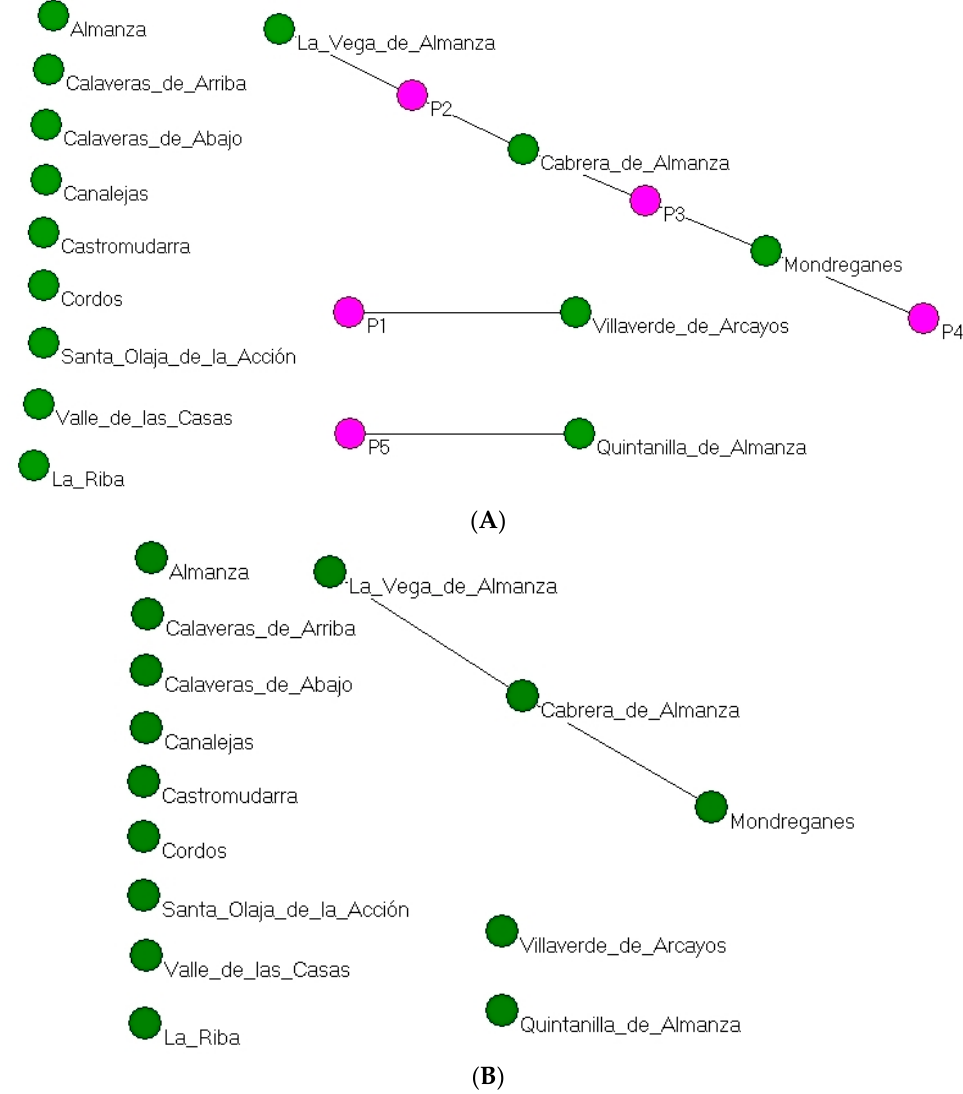
Figure 6. ( A ) Two-mode network of municipalities in which deliveries occurred and the TBAs who attended them (pink: TBAs; green: localities); ( B ) One-mode network of municipalities by co-occurrence of deliveries attended by TBAs.